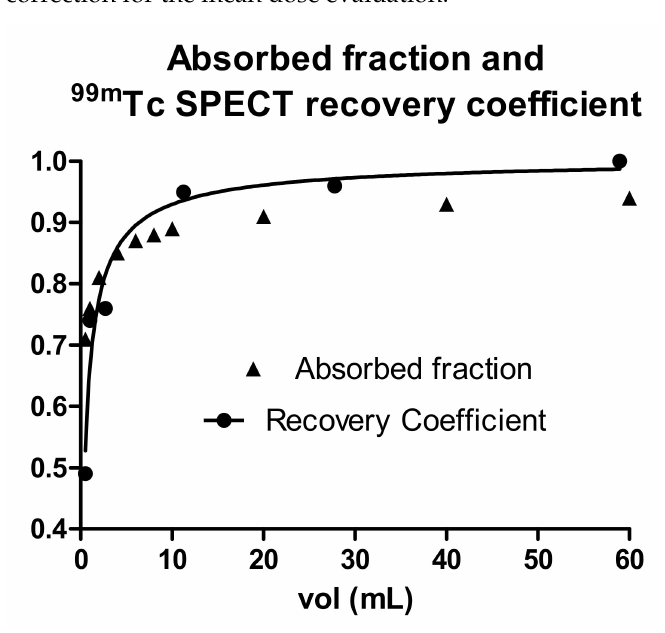
Figure 8. Dependence of the absorbed fraction and recovery coefficients on the sphere